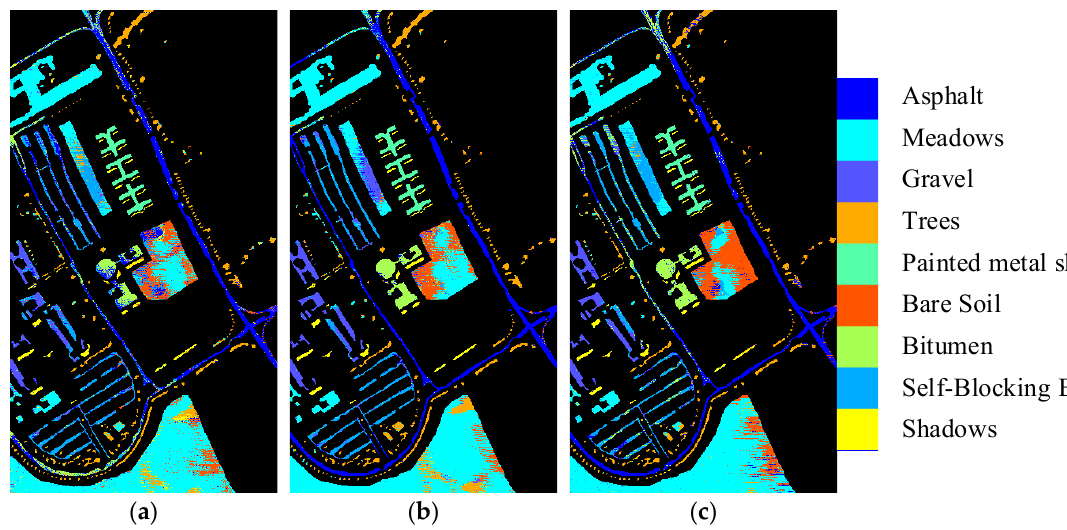
Figure 13. Classification maps on the UP dataset based on different number of training samples. ( a ) Sample = 5; ( b ) Sample = 10; ( c ) Sample =